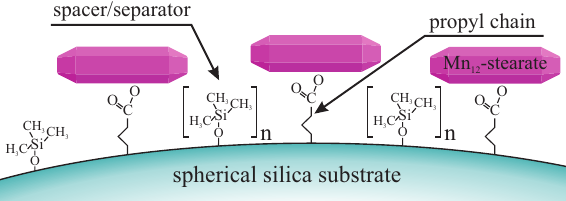
Figure 17. A schematic illustration of the spherical silica acting as a 2D solid solvent for the Mn 12 -stearate single-molecule magnets; n denotes the number of spacer units, separating single-molecule